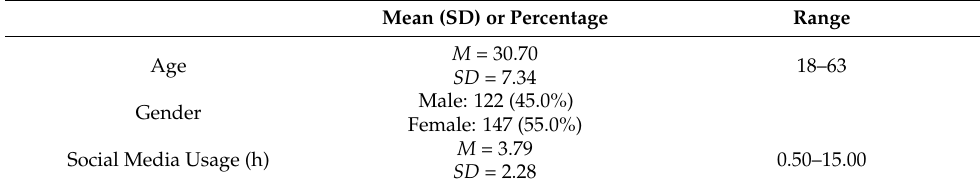
Table 2. Characteristics of the study participants ( n =